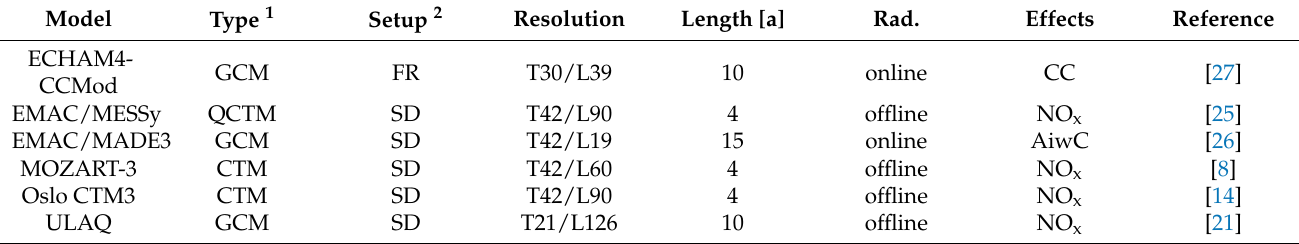
Table 2. List of global comprehensive atmospheric models used; describing type, setup, horizontal/vertical resolu- tion (this is to follow the columns in the table), setup, simulation length, calculation method for radiative changes and effects